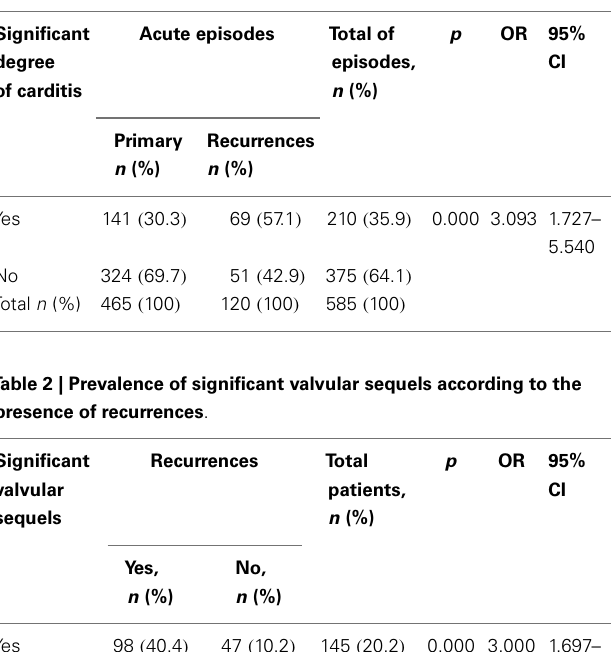
Table 1 | Prevalence of significant carditis at primary episodes and recurrences .